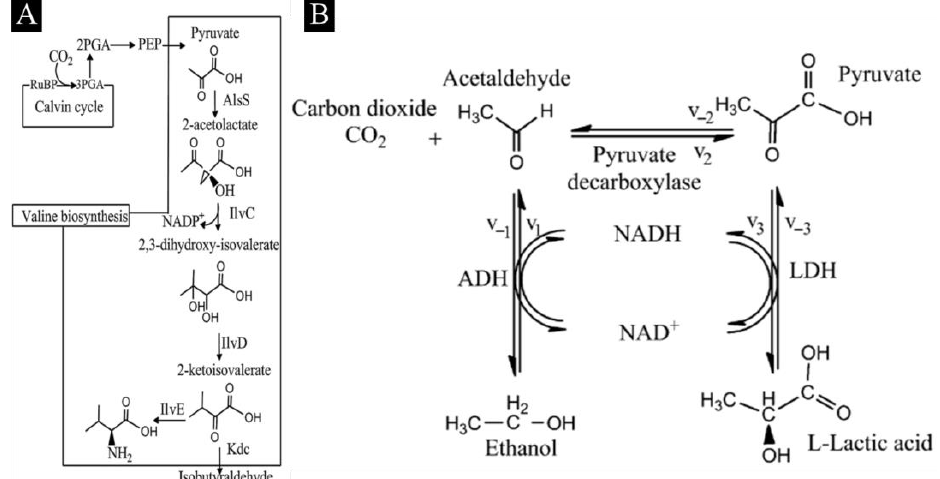
Figure 5. ( A ) Themultienzyme routefor thesynthesis of isobutyraldehyde from CO 2 . AlsS: acetolactate synthase; IlvC: acetohydroxy acid isomeroreductase; IlvD: dihydroxy-acid dehydratase; Kdc: 2- ketoacid decarboxylase, Reproduced with permission from Tong et al. [78] Copyright 2011 Wiley. ( B ) The multienzyme route for the synthesis of L-lactic acid from CO 2 and ethanol. Originally published in Atsumi et al. [79] under Creative Commons Attribution 4.0 International